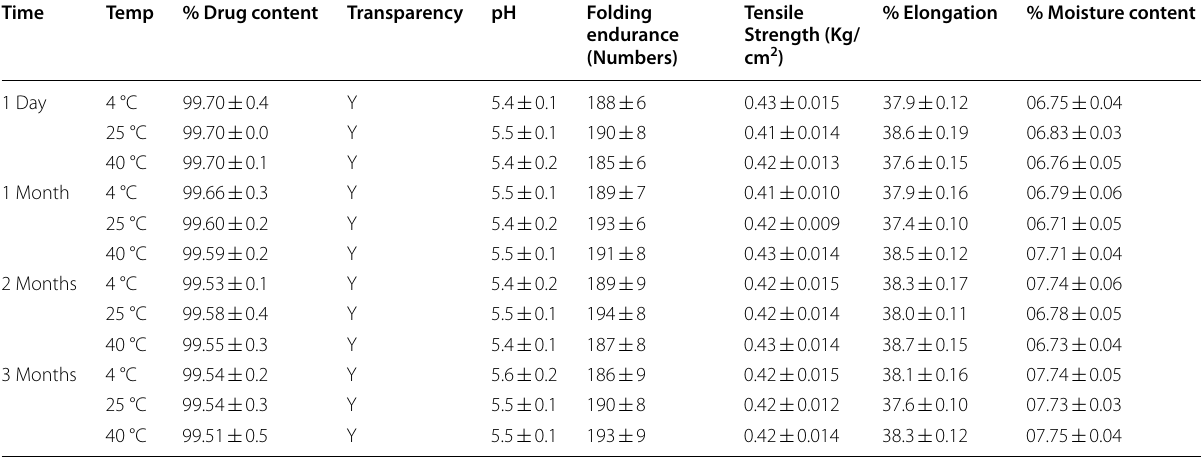
Table 10 Stability study of optimized primaquine-loaded transdermal patch formulation (F5) Time